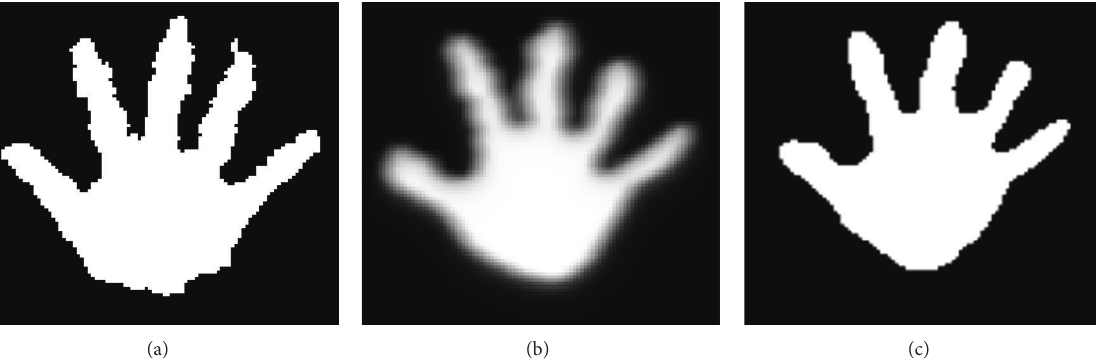
Figure 5: Binarized right hand images; (a) once binarized image, (b) blurred image with 7 ∗ 7 average filter, and (c) twice binarized image.